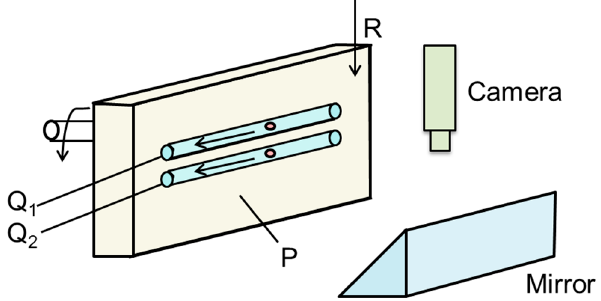
Figure 11. Schematic drawing of the apparatus for measuring viscosity in a superconducting magnet [58].